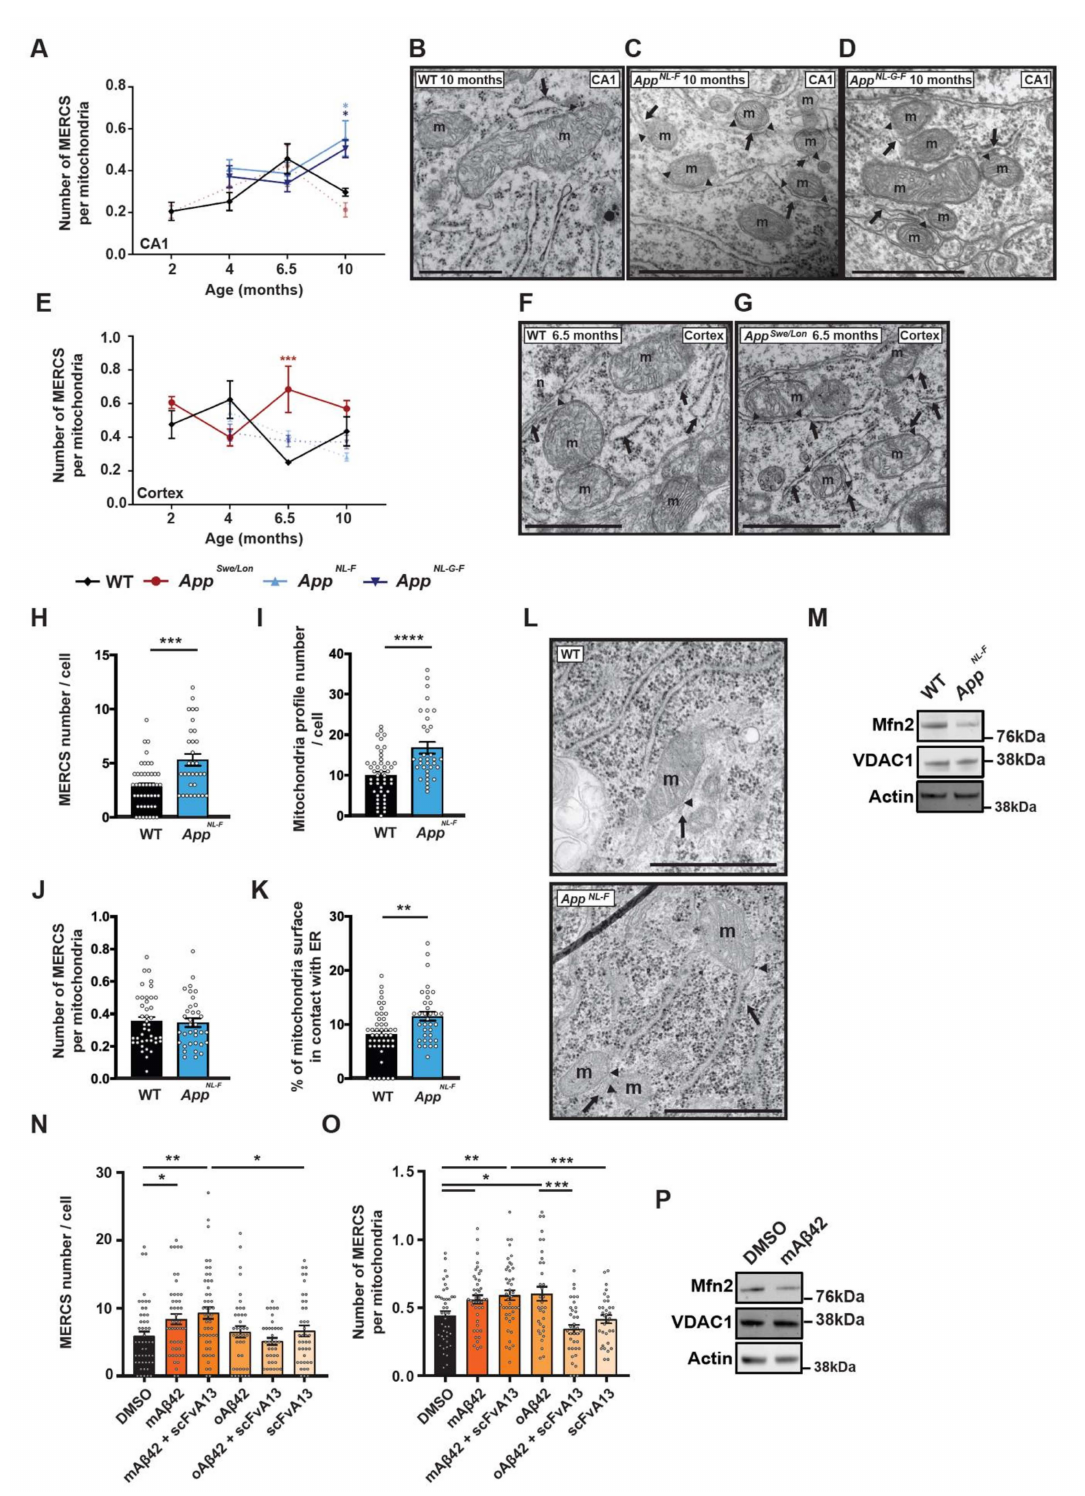
Figure 2. MERCS are increased in Alzheimer’s disease (AD) mouse models and primary cortical neurons (PCN) with increased amyloid β -peptide (A β 42). Quantification of number of MERCS per mitochondria in ( A ) CA1 ( p = 0.021 App NL-F , p = 0.051 App NL-G-F )—electron micrographs from 10 months animals, ( B